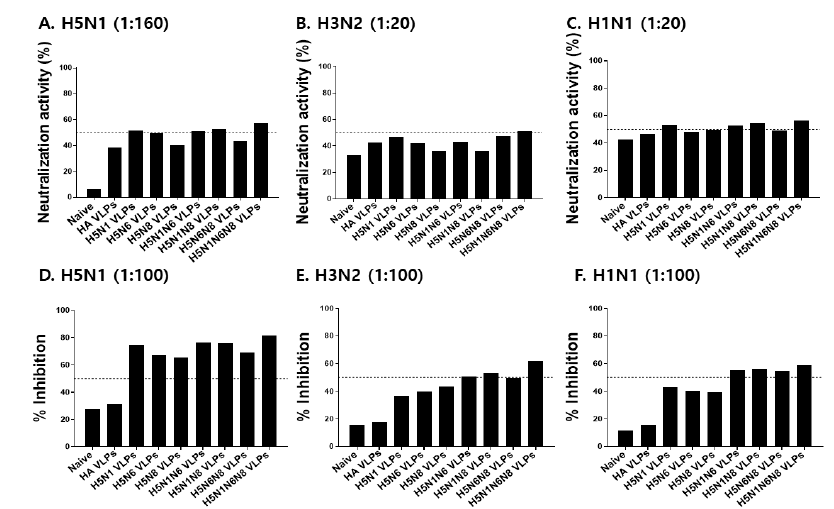
Figure 3. Viral neutralizing activity and neuraminidase inhibition activity against H5N1, H3N2, and H1N1 influenza viruses. Mouse sera at 4 weeks after boost immunization were used at various serum dilutions to determine viral neutralizing activity and neuraminidase inhibition activity. Microneutralization activities against H5N1 ( A ), H3N2 ( B ), or H1N1 ( C ) influenza viruses were determined in MDCK cells seeded in 96 well plates. NA inhibition activity was determined by an enzyme-linked lectin assay against H5N1 ( D ), H3N2 ( E ), or H1N1 ( F ) influenza viruses. The dotted line indicates 50% of virus-neutralizing activity and 50% of neuraminidase inhibition activity.